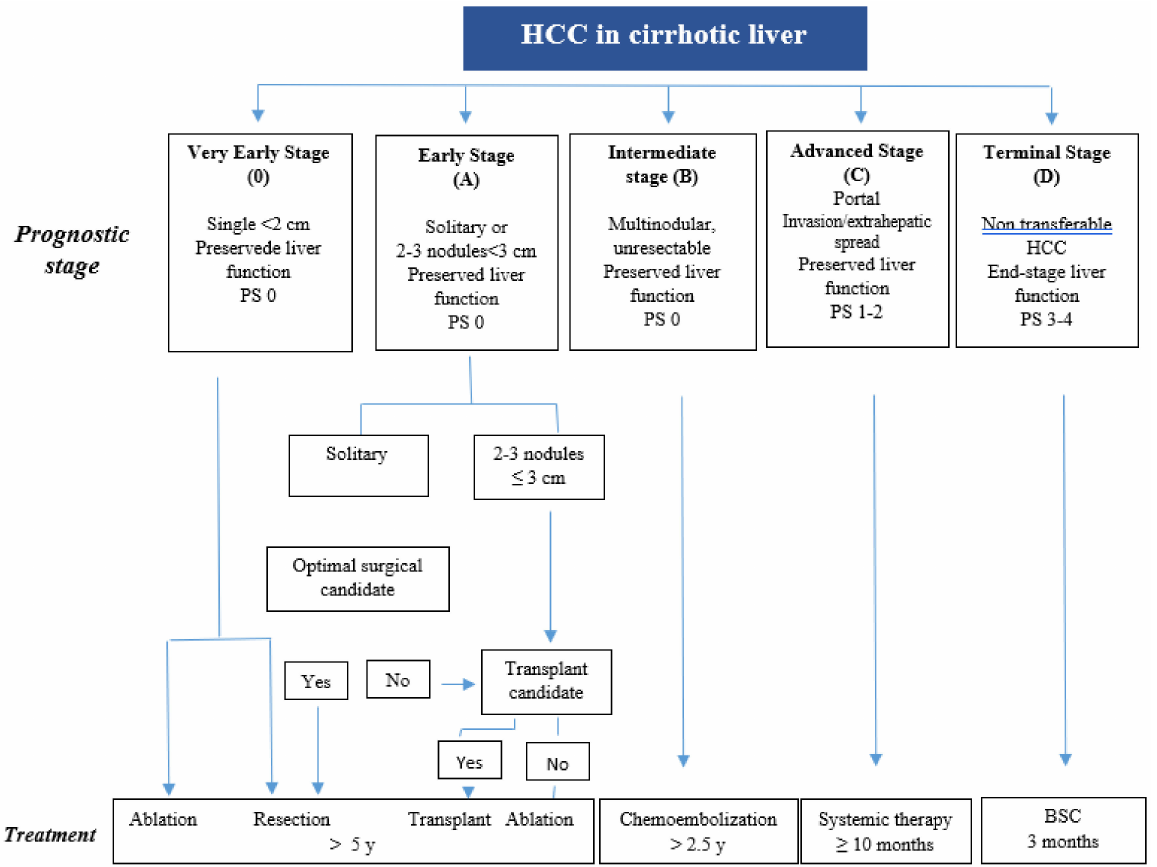
Figure 1. EASL Clinical Practice Guidelines: Management of hepatocellular carcinoma (J Hepatology